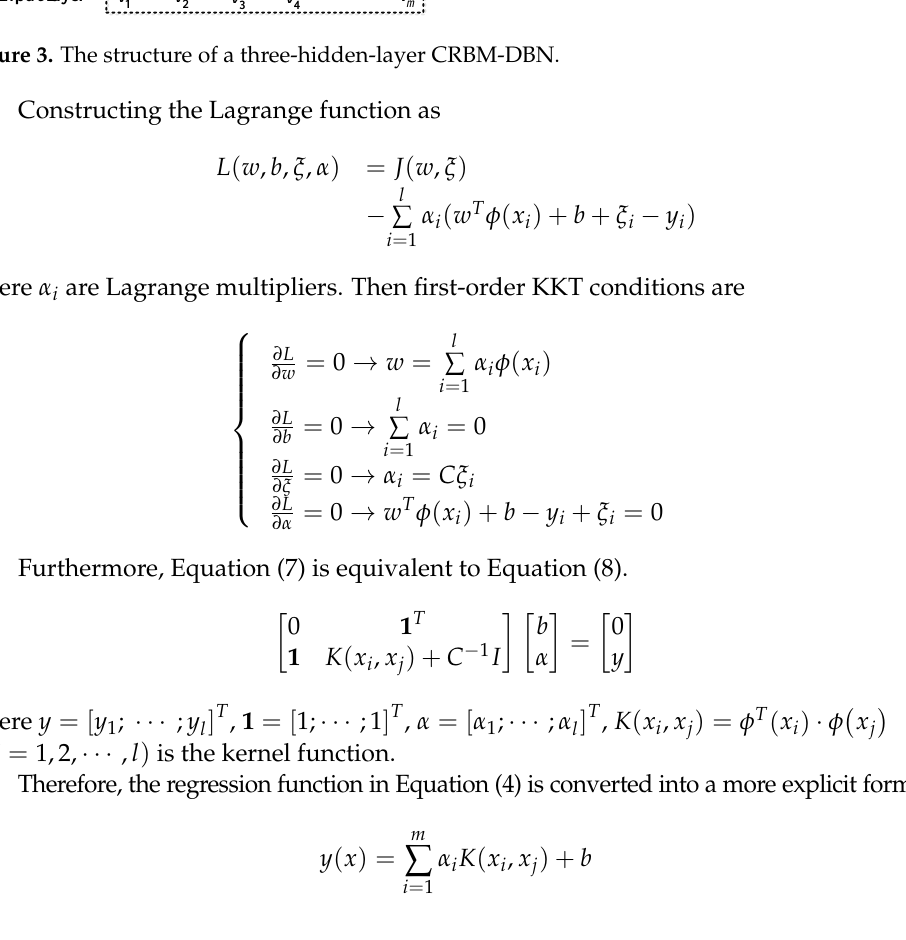
Figure 3. The structure of a three-hidden-layer